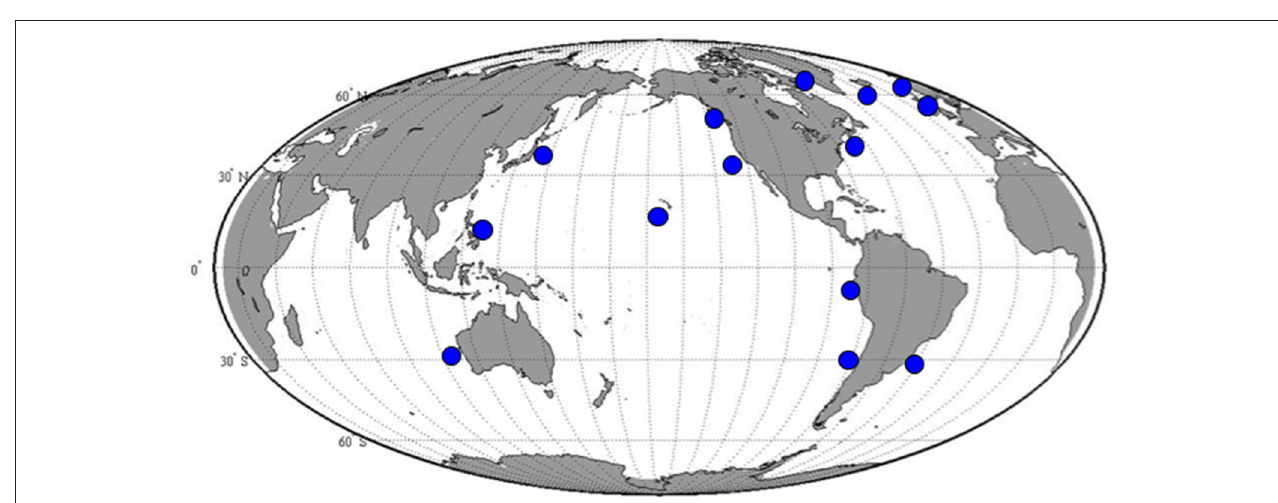
Frontiers in Marine Science |